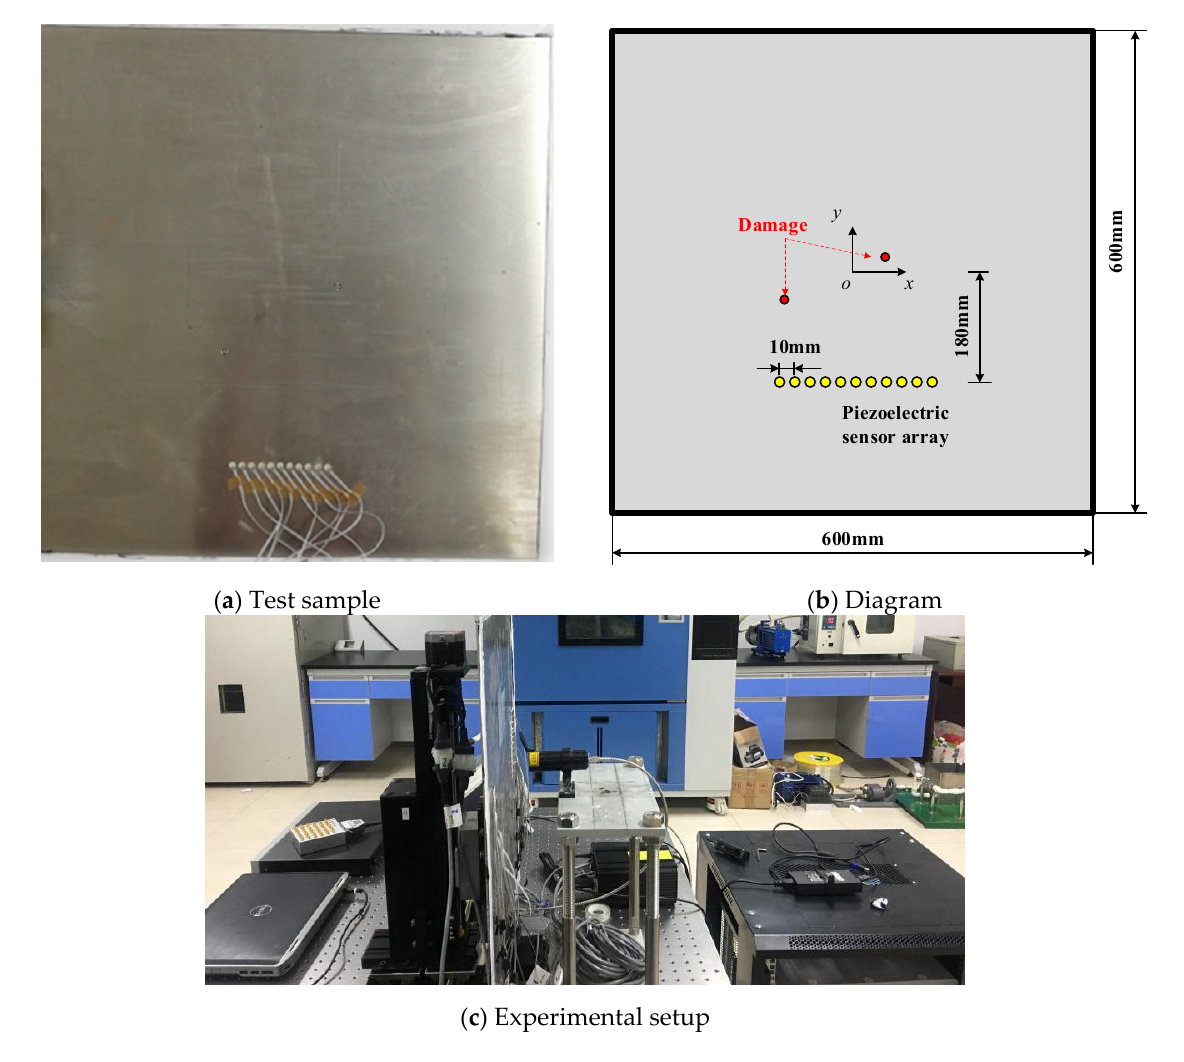
Figure 16. Test sample and experimental setup.